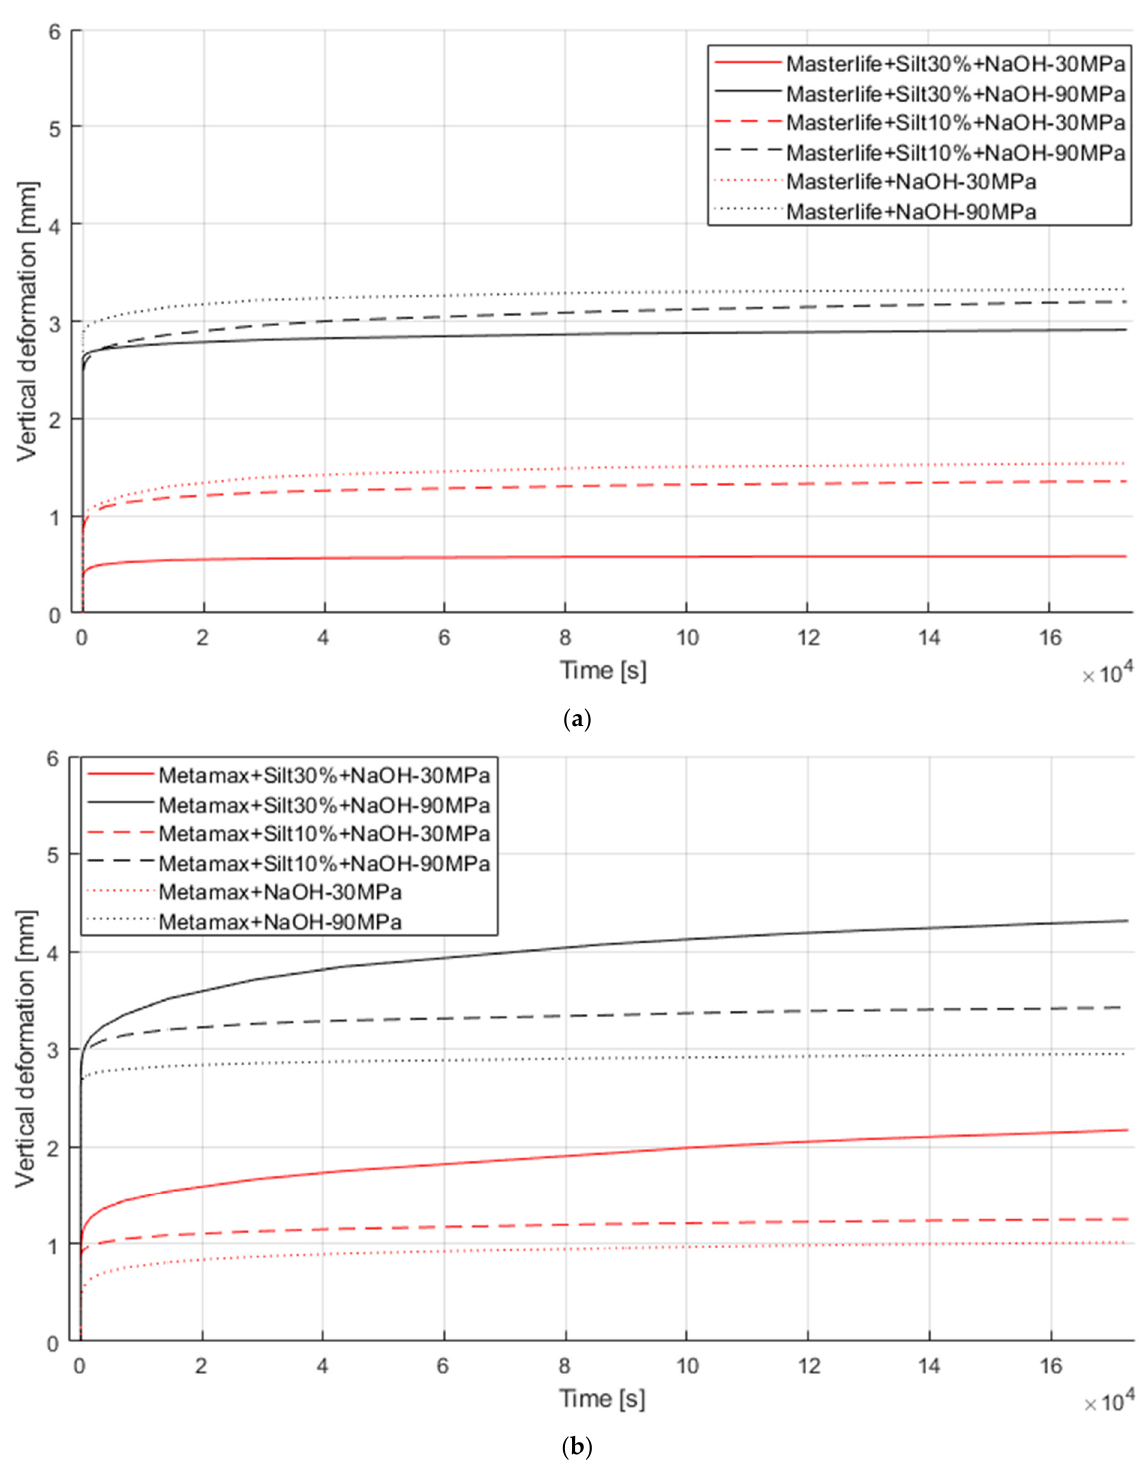
Figure 5. Oedometric tests on samples using vertical pressures of 30 MPa and 90 MPa (red and black curves, respectively) for 48 h: panel ( a ) shows sample 1 (dotted line), sample 2 (continuous line) and 3 (dashed line), panel ( b ) shows sample 4 (dotted line), sample 5 (continuous line) and 6 (dashed line).